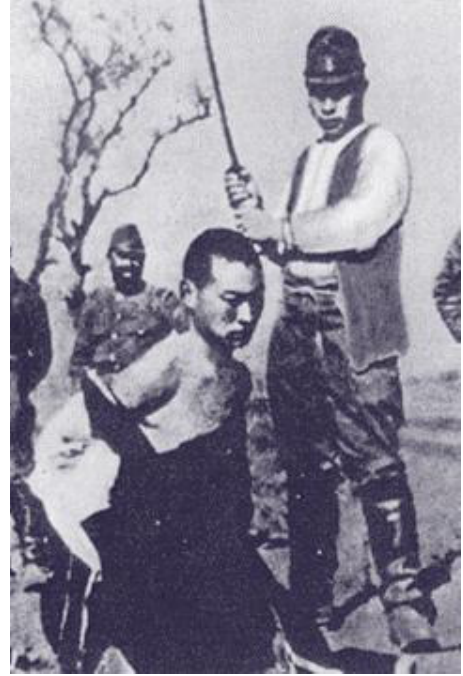
Figure 8. Beheading a Chinese soldier. Source: Robyn Beck/Getty Images.